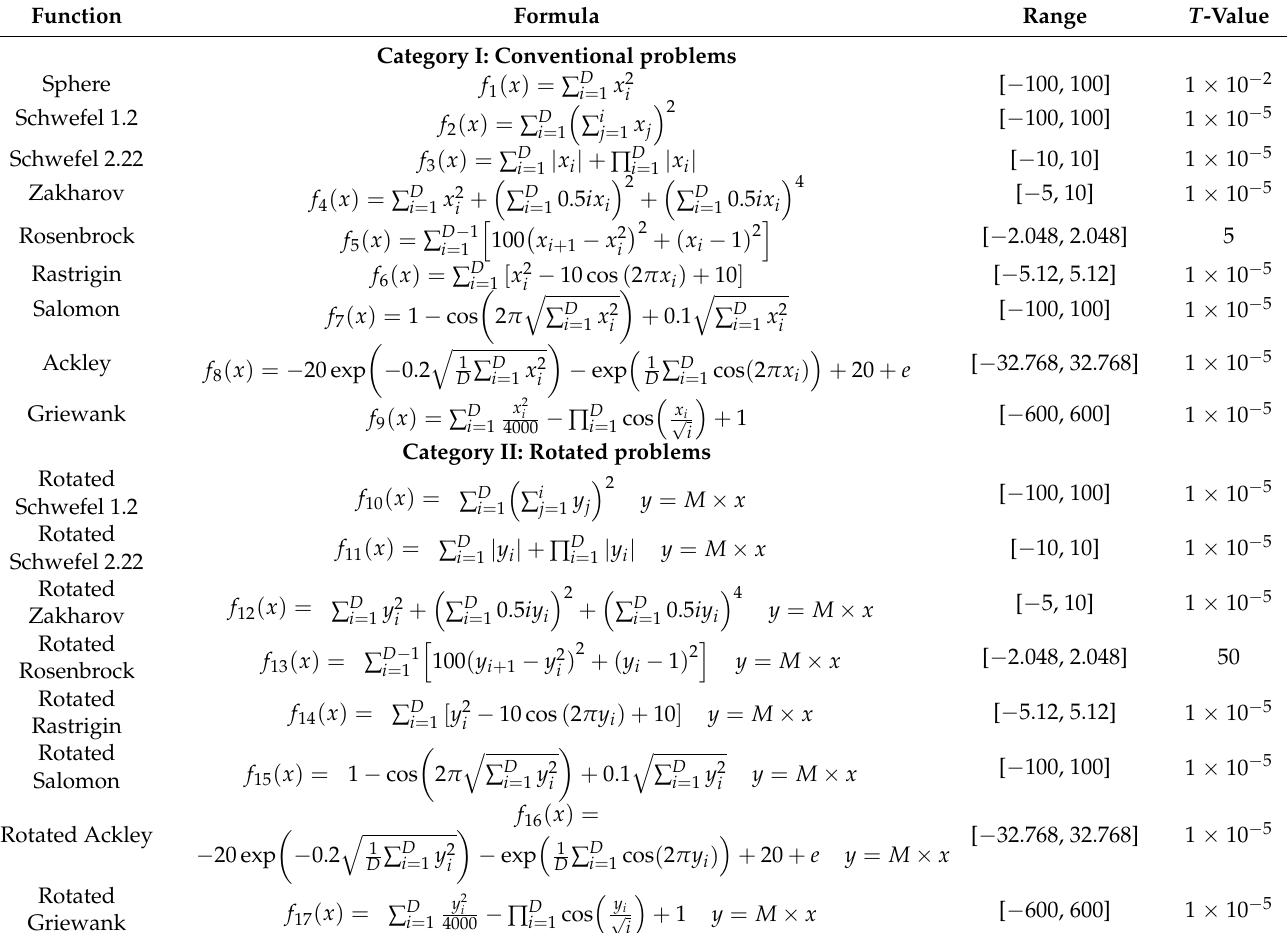
Table 4. Benchmark functions considered in